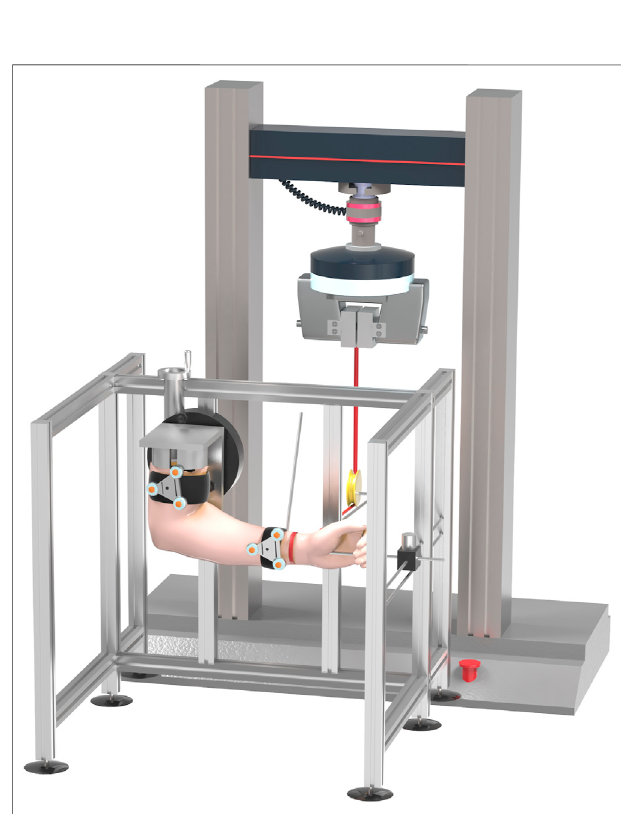
FIGURE 2 | Schematic illustration of testing system. This image shows test under valgus stress with 2 Nm of torque, whereas elbow is in 90 ° of fl exion, and forearm is in